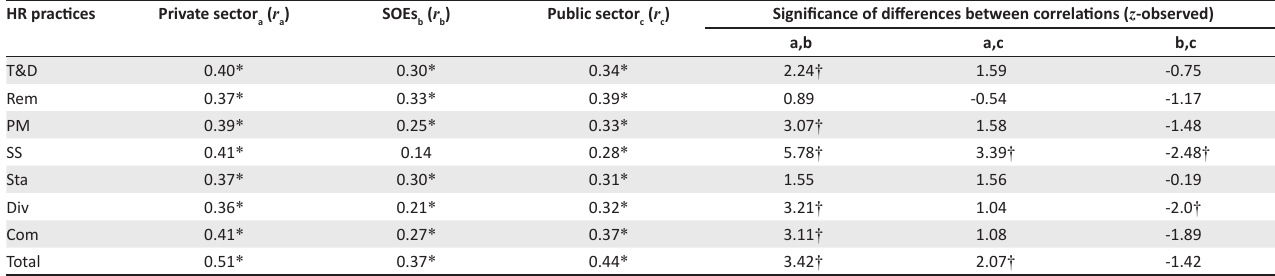
TABLE 4: Correlation between human resource practices and organisational commitment, as well as differences in the correlations. HR practices